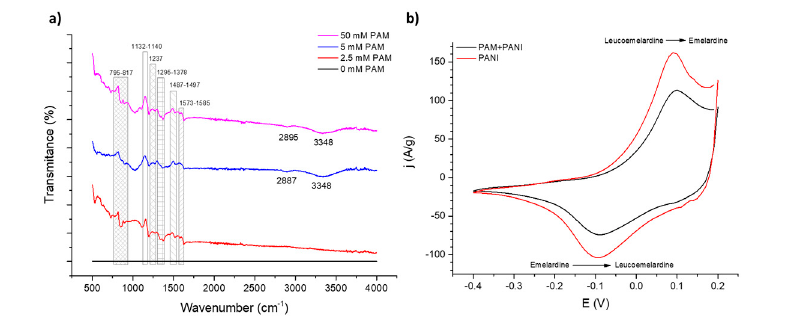
Figure 3. ( a ) FTIR results for PAM imprinted PANI using different PAM concentrations; ( b ) electrochemical conformation of imprinted PANI by 5 mM PAM